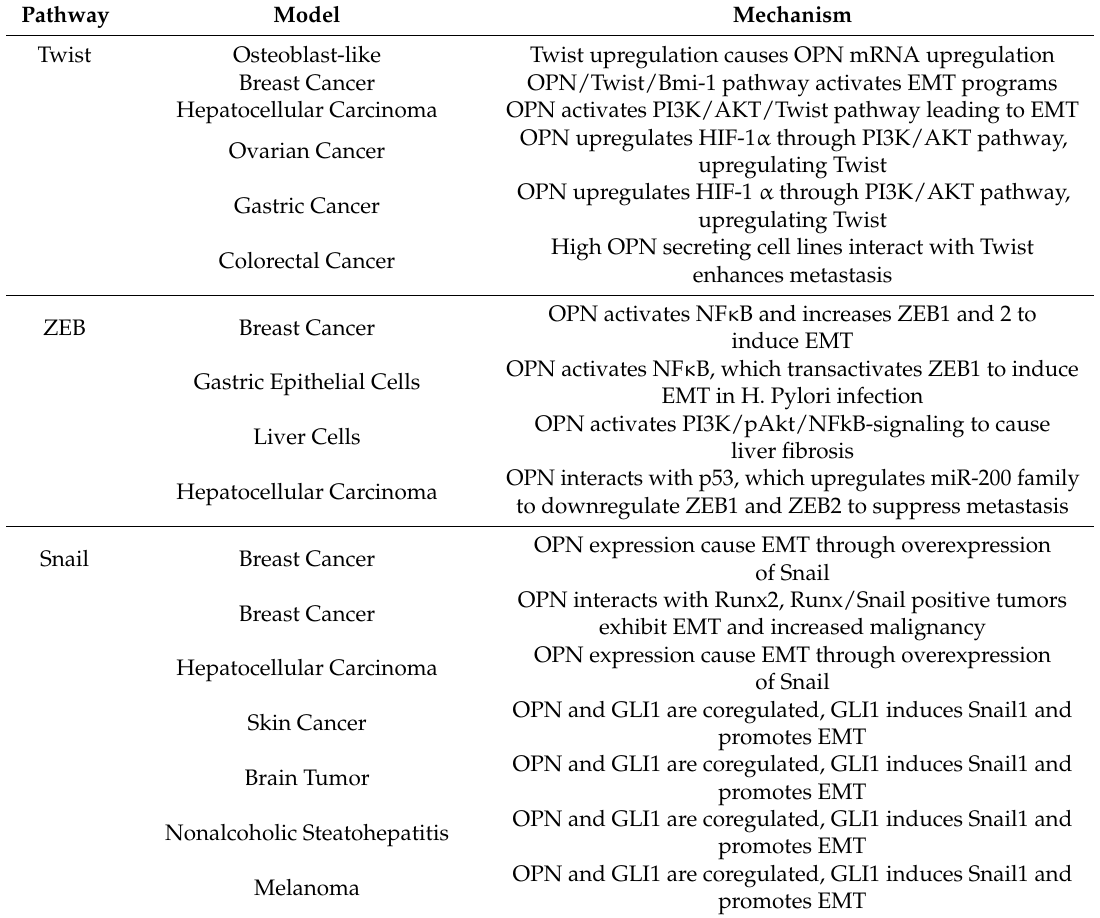
Summary of current evidence linking osteopontin to epithelial-mesenchymal transition